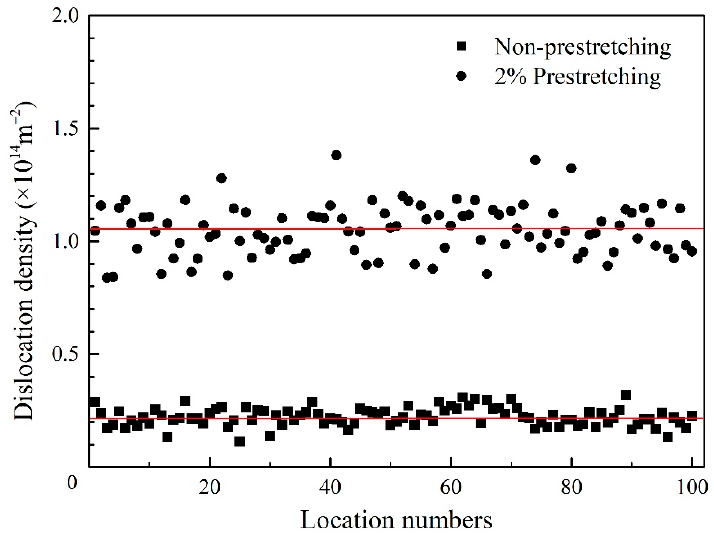
Figure 7. Measured dislocation density of the non-pre-stretched and 2% pre-stretched AA2195 specimens.